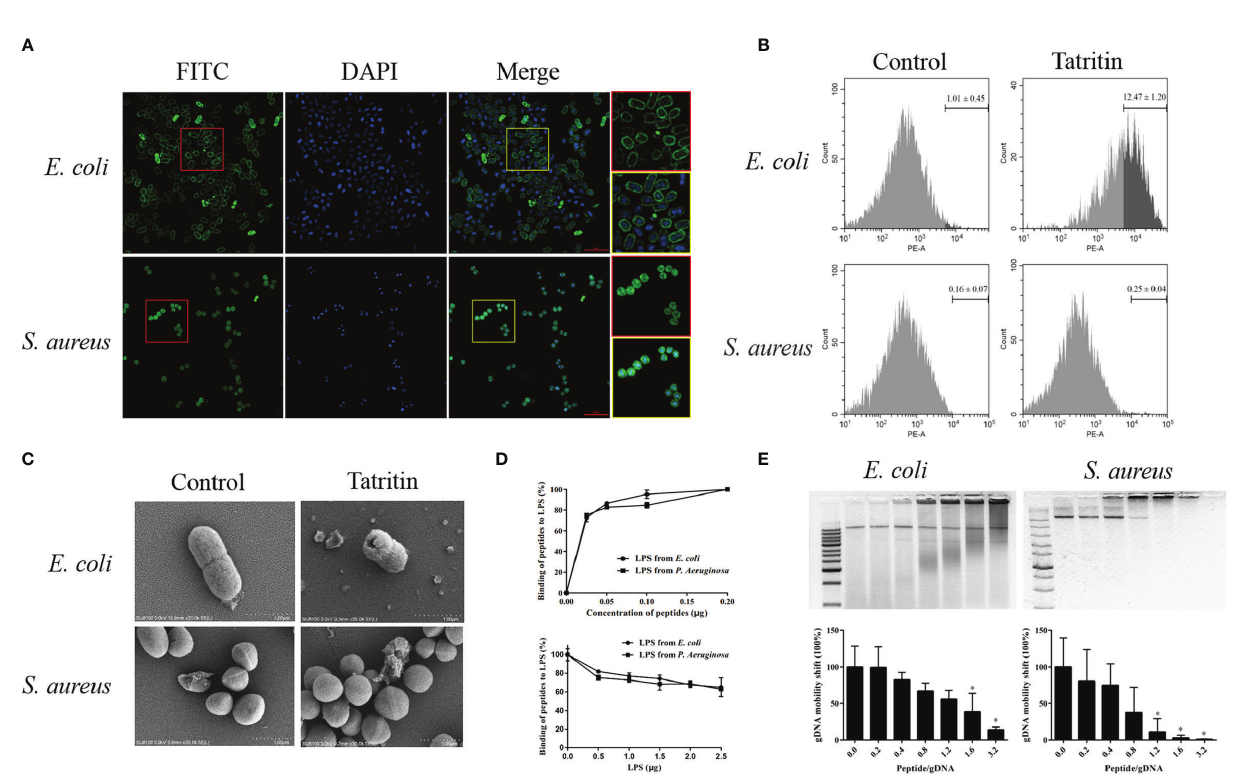
FIGURE 6 | Function and mechanism of Tatritin in antibacterial process. (A) Localization of Tatritin peptide on the bacteria. Approximate 1 – 5 × 10 8 CFU of E. coli ATCC35218, and S. aureus ATCC6538 were incubated with FITC-labeled Tatritin (2.5 m M) for 1 h. The bacteria were washed, fi xed, and stained with DAPI (blue). Images were taken using confocal microscope. The cells in the red and yellow boxes were enlarged. Scale bar is 5 m m. (B) PI labeling of bacterial cells treated with Tatritin peptide. Approximately 5 × 10 7 cells in 50 µl PBS were added to an EP tube containing 150 µl of Tatritin (10 µM). Then PI was added, and the in fl ux of PI into bacterial cells was investigated by fl ow cytometry. All bacteria were gated, and the cell-penetrating ef fi ciency was determined using the data from three tests. (C) Scanning electron microscope of E. coli and S. aureus cultured with or without Tatritin (20 µM) for 2 h at 37 ˚ C. (D) Evaluation of the LPS-binding activity of Tatritin. The LPS-binding activities of Tatritin were investigated by incubating 0.05 – 0.2 µg of Tatritin in the LPS-immobilized 96-well microtiter plates (0.2 µg LPS/well) for 1 h at 37°C in 50 µl of RPMI 1640. The bound peptides were detected by TMB reaction using rabbit anti-Tatritin and HRP-conjugated goat anti-rabbit IgG. Tatritin (0.2 µg/well) was incubated in the LPS-immobilized 96-well microtiter plates for 1 h at 37°C in the absence or the presence of LPS (0.5 – 2.5 µg/well) in 50 µl of RPMI 1640, and the bound peptide was detected as described above. Binding of Tatritin to the LPS-immobilized plates was expressed as a percentage of that incubated with 0.2 µg of each peptide in the absence of added LPS. Data are the mean ± SD (n = 3). (E) Gel shift assay of bacterial gDNA of E. coli and S. aureus mixed with increasing concentrations of Tatritin. The abscissa represents the peptide/gDNA ratio. ImageJ was used to analyze the intensity of nucleic acid bands in gel shift assay. The abscissa represents the peptide/gDNA ratio and the ordinate represents the gDNA mobility shift,